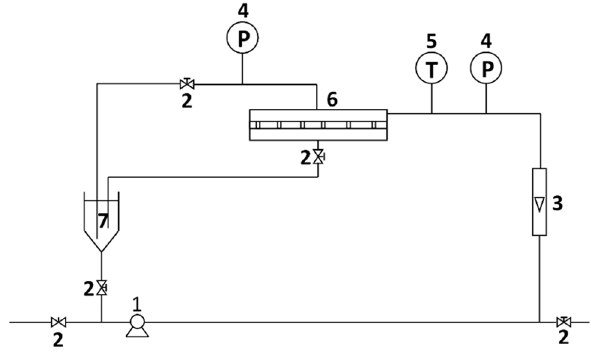
Fig. 1 Schematic diagram of cross-flow filtration experimental equip- ment [1—Centrifugal pump; 2—Valves; 3—Rotameter; 4—Pres- sure gauges; 5—Temperature gauge; 6—Ceramic membrane module plate; 7—Feed